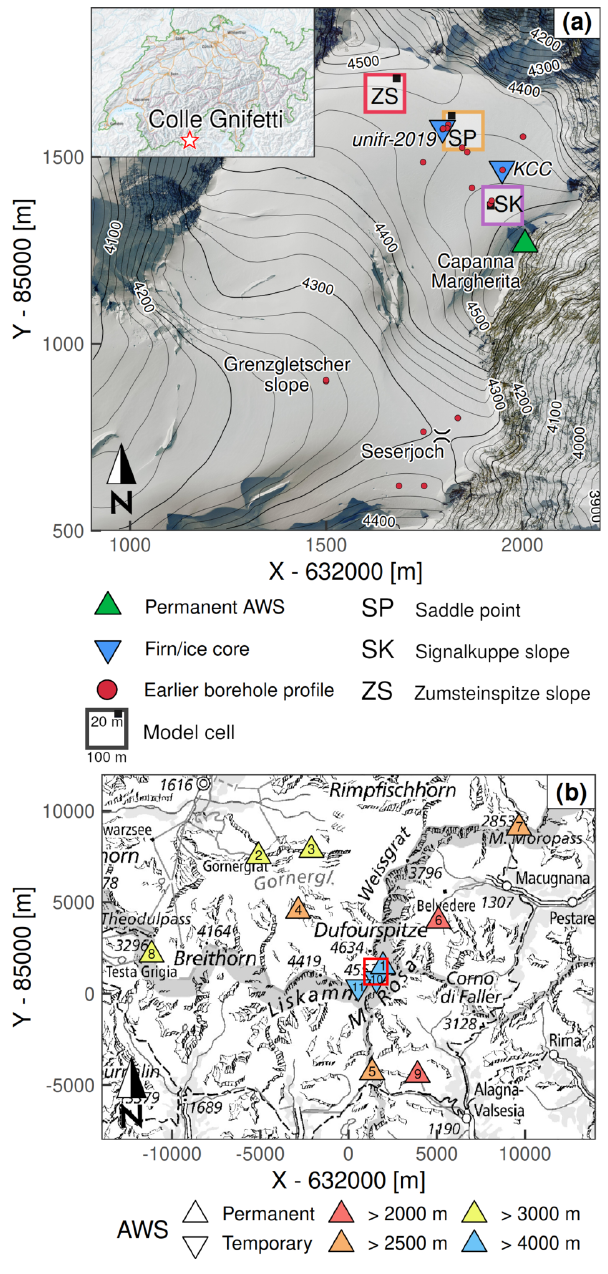
Figure 1. (a) Location map of the Colle Gnifetti area. Labeled model cells across the saddle correspond to the point series in Figs. 6–10. Several borehole locations were measured more than once (also see Fig. 5). (b) Overview map of the Monte Rosa range with AWS locations (see Table 2 for more information). The red square shows the extent of Fig. 1a. In both panels x and y are met- ric CH1903/LV03 coordinates. Orthophoto and topographic map source: Federal Office of Topography